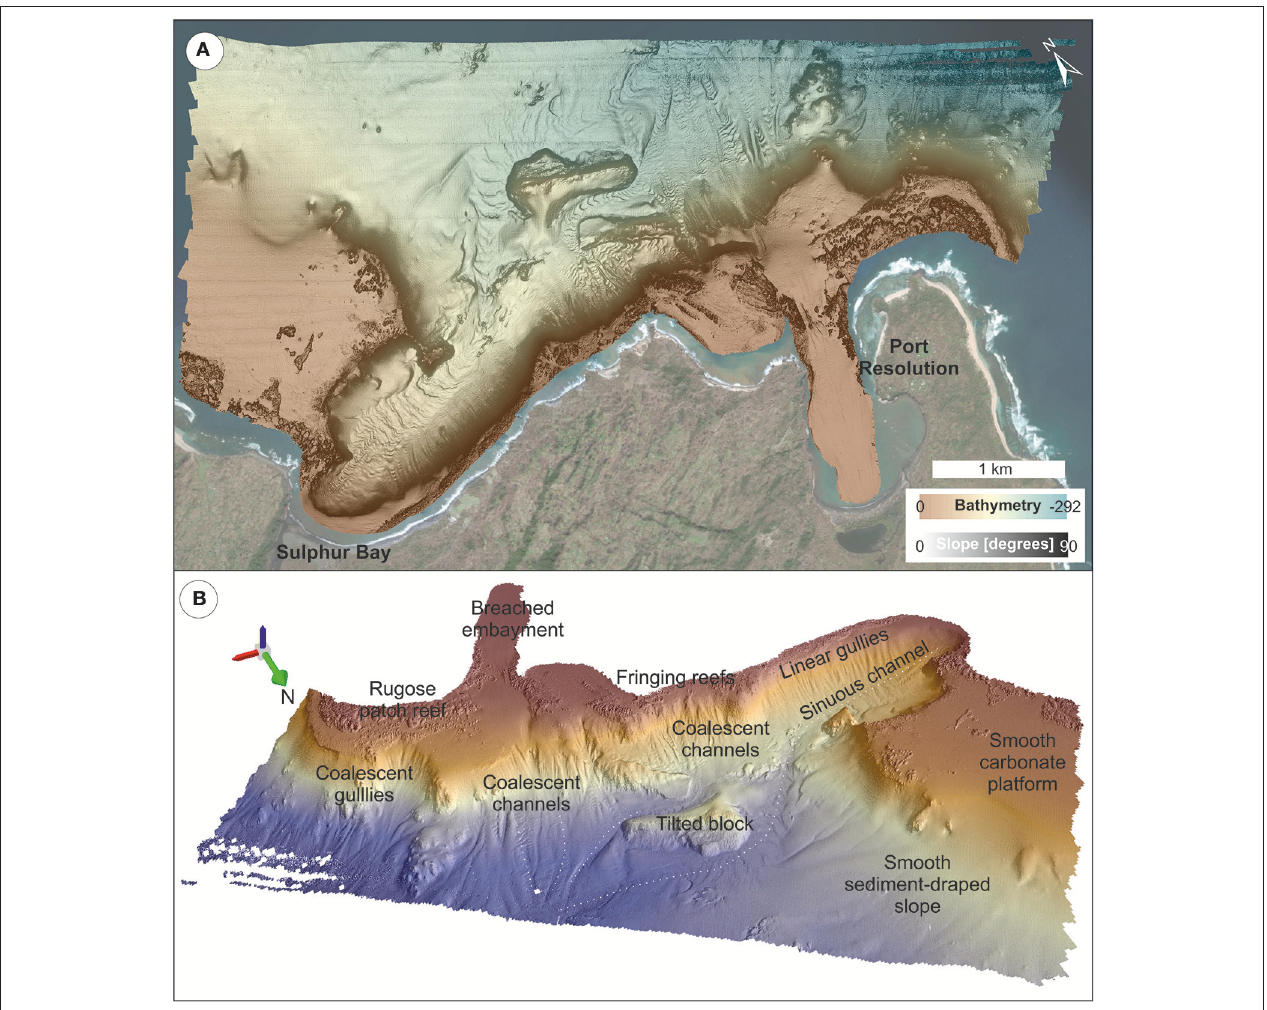
FIGURE 2 | Overview of seafloor topography and main features in the study area. (A) Colourwash bathymetry overlain on greyscale slope map. Terrestrial data from Google: Digital Globe. (B) 3D rendering (3 × vertical exaggeration) of hillshaded bathymetry (illumination from the north-west) annotated with main geomorphologic features and north-arrow